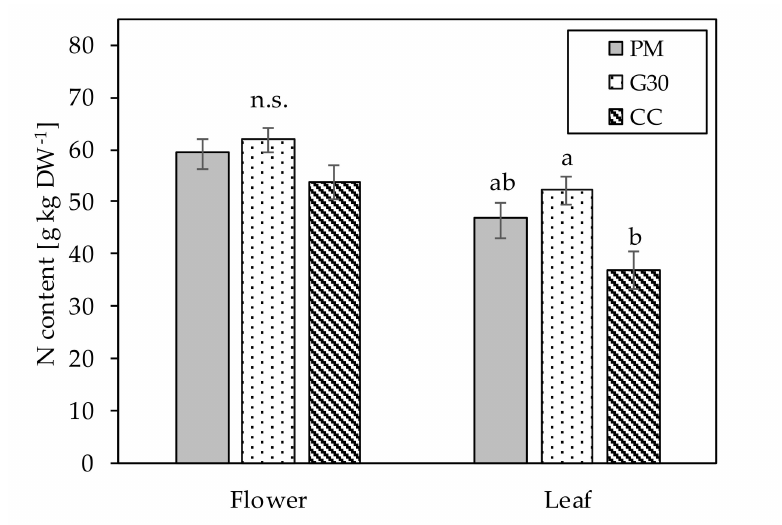
Figure 3. Mean nitrogen (N) content of flower and leaf tissues of genotypes treated with peat-mix media (PM), peat-mix + 30% green fibre (G30) and 100% coco coir fibre (CC). Means with at least one identical lowercase letter did not di ff er significantly at α = 0.05; n.s. = not